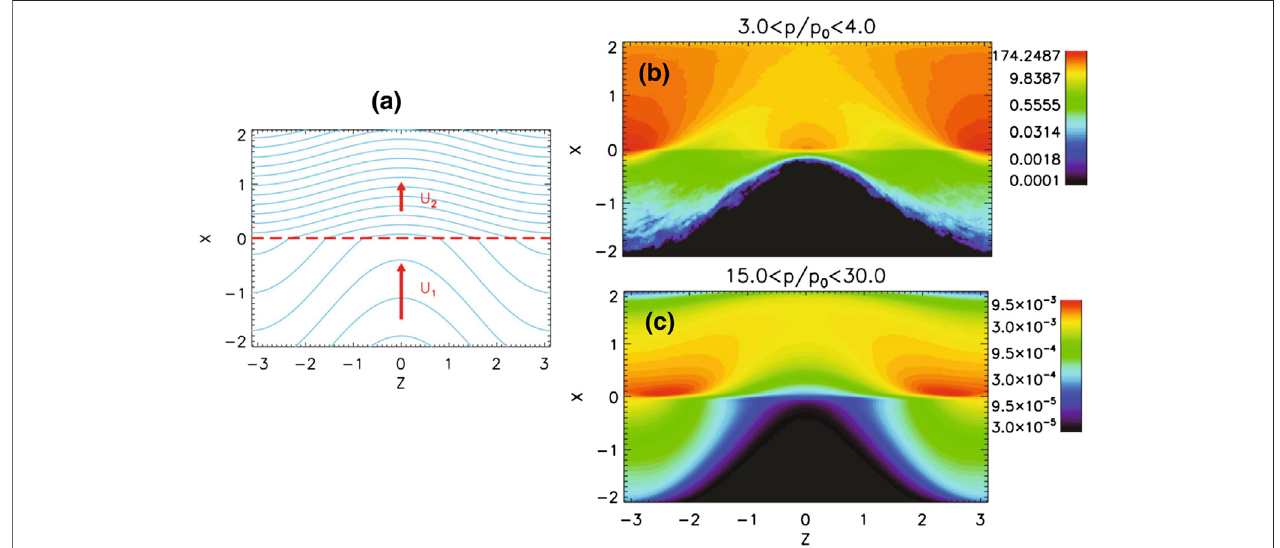
FIGURE 8 | (a) Shock and magnetic fi eld geometry for an upstream average magnetic fi eld perpendicular to the shock normal. The blue lines represent the magnetic fi eld lines and the red dashed line indicates the shock wave. (b) Representation of density contour of accelerated particles, for the energy range 3 . 0 < p / p 0 < 4 . 0, where p 0 is the initially injected momentum. (c) similar to (b) but for 15 . 0 < p / p 0 < 30 . 0 (adapted from Guo et al., 2010). Reproduced by permission of the